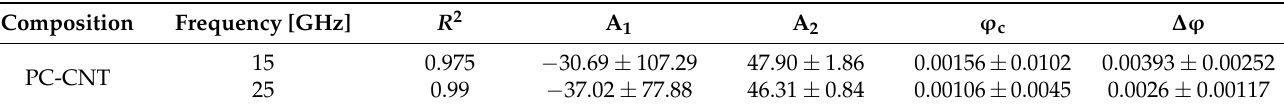
Figure 16. Experimental absorption ratio and Steffen–Boltzmann (SB) fit at 15–25 GHz for PC- CNT composites. Table 2. Steffen–Boltzmann parameters values obtained from fitting electromagnetic absorption ratio against volume fraction experimental curves at 15 and 25